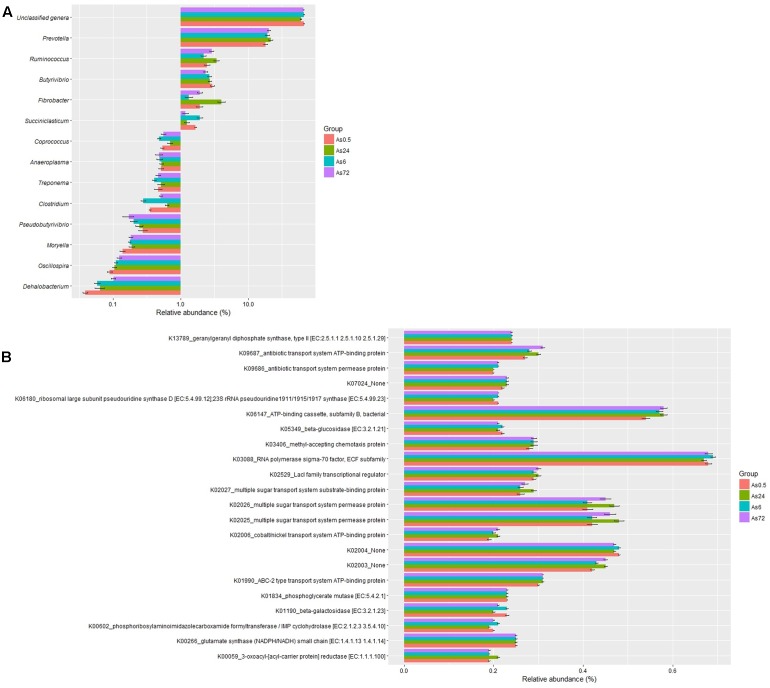
Relative abundances (A) and predicted function (B) of bacteria loosely (As) attached to rice straw after 0.5, 6, 24, and 72 h incubation in the rumen of cows by Illumina MiSeq sequencing of 16S rRNA gene. (n = 6; the relative abundances of bacteria above 0.1% or the relative abundances of KEGG Orthologies above 0.2% in at least one sample were presented.)